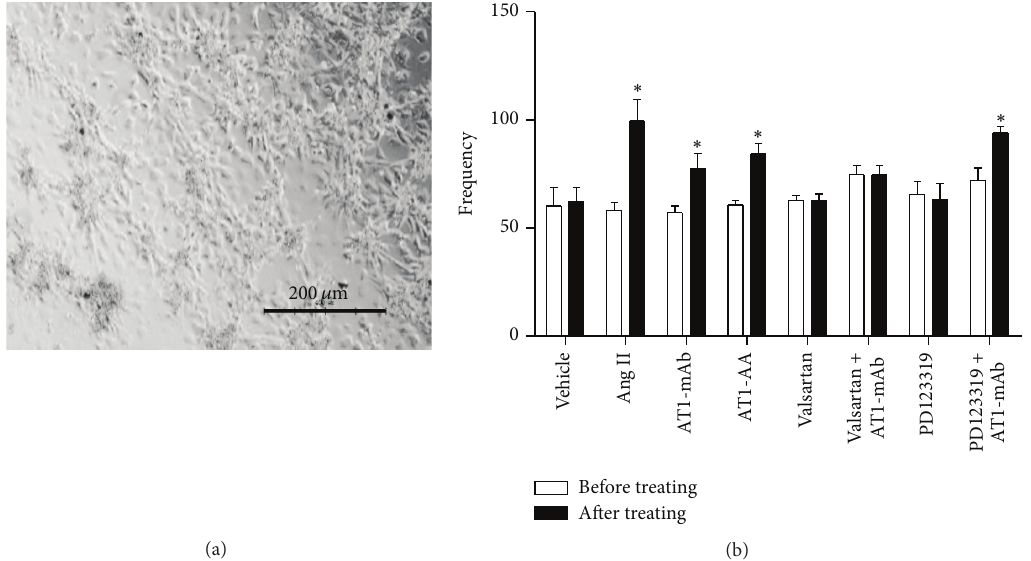
Figure 3: Biological activity of AT1-mAb was identified by changes in beat frequency of neonatal rat myocardial cells. (a) Cultured neonatal rat myocardial cells. Scale bar = 200 𝜇 m. (b) Different processing factors had different effects on beating frequency of cultured neonatal rat myocardial cells in vitro . ∗ 𝑃 < 0.05 versus before treating. Data represent the mean ± SEM; 𝑛 = 6